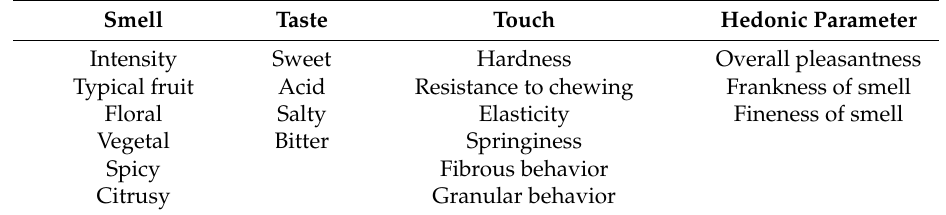
Table 1. Descriptive parameters of the organoleptic fruit profiles in terms of smell, taste and touch (rheological features during chewing) ranked by